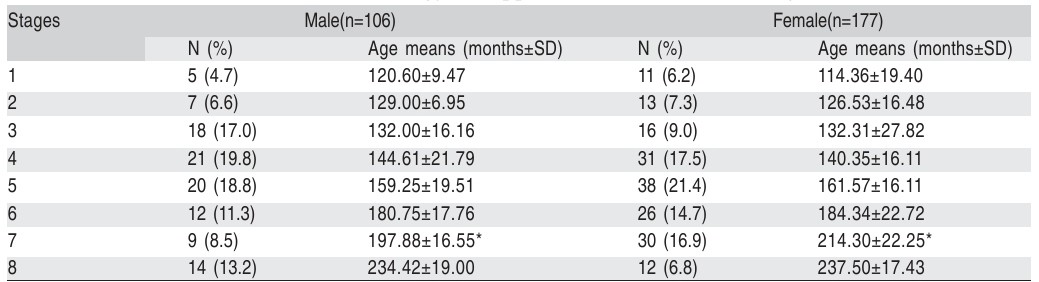
Table 3. Tooth mineralization chronology of upper third molars according to sex.